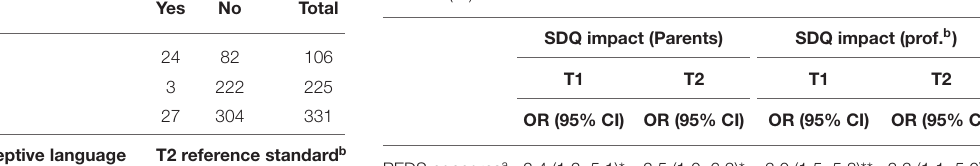
TABLE 5 | Logistic regression analysis (significant interaction with one or both risk factors): association between PEDS concerns about expressive and receptive language development and SDQ impact according to parents and professional caregivers at the age of 3 and 4 years; odds ratios (OR) and 95% confidence intervals